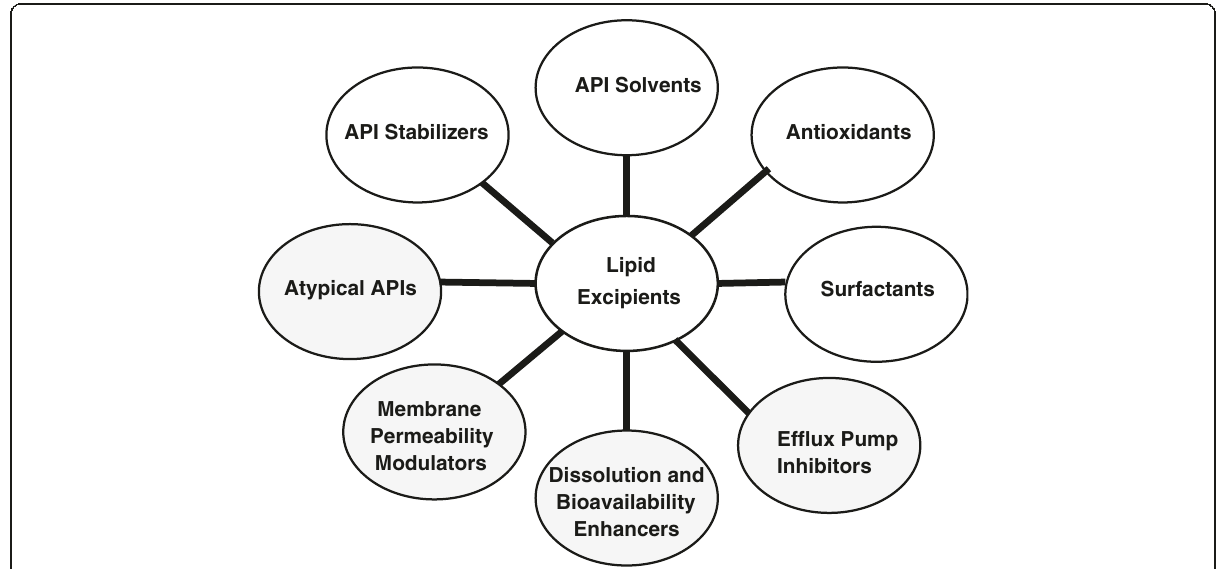
Table 3 Traditional and Non-Traditional Uses of Minerals in Pharmaceuticals (Rowe et al. 2009; Boddu et al. 2015; Haydel et al. 2008, Gershkovich et al.; 2009; Constantinides 2014) Minerals Traditional Uses as Functional Excipients Non-Traditional Uses as Atypical Active Kaolin, Montmorillonite (bentonite), Magnesium Aluminum Silicate, Talc (hydrated magnesium silicate), Precipitated Calcium Carbonate, Calcium sulfate, Dibasic Calcium Phosphate, Magnesium Carbonate, Colloidal Silicon Dioxide, Sodium Chloride